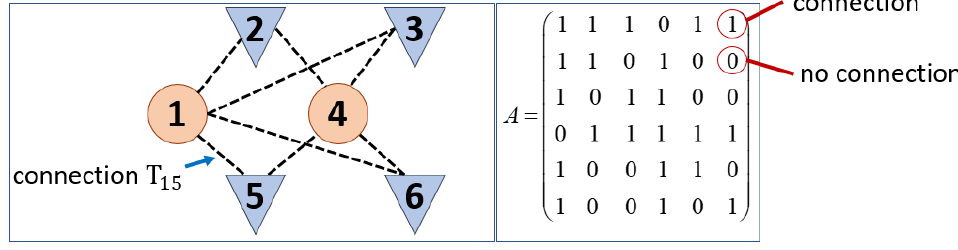
Figure 4. An example of setting the connectivity matrix A for injectors